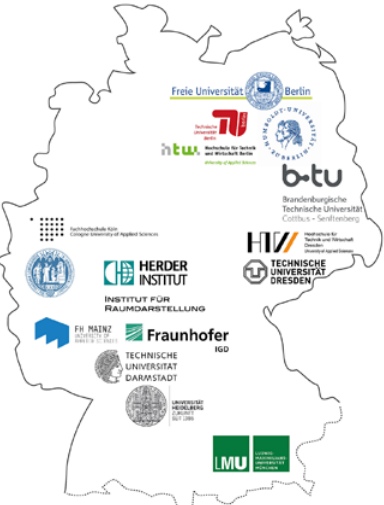
Figure 1 – Institutions of the members of the digital reconstruction workgroup of the Digital Humanities in the German-speaking area association (Digital Humanities im deutschsprachigen Raum